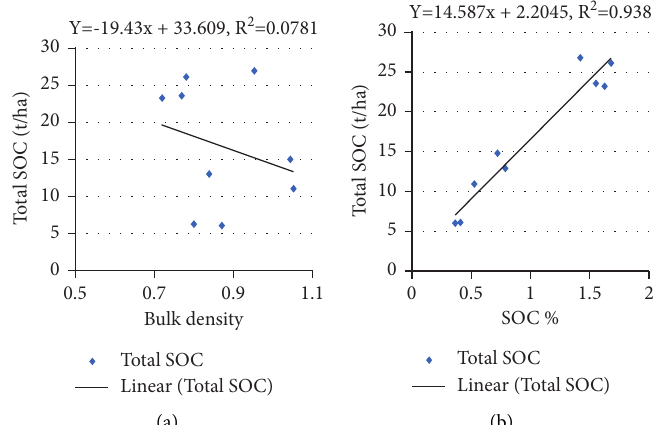
Figure 4: (a) SOC stocks (t/ha) and BD. (b) SOC stock (t/ha) with SOC concentration in Chir pine forest.